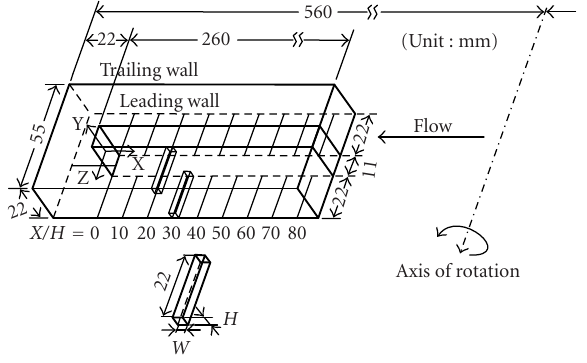
Figure 1: Sketch of configuration, coordinate system, and dimen- sions of test section.